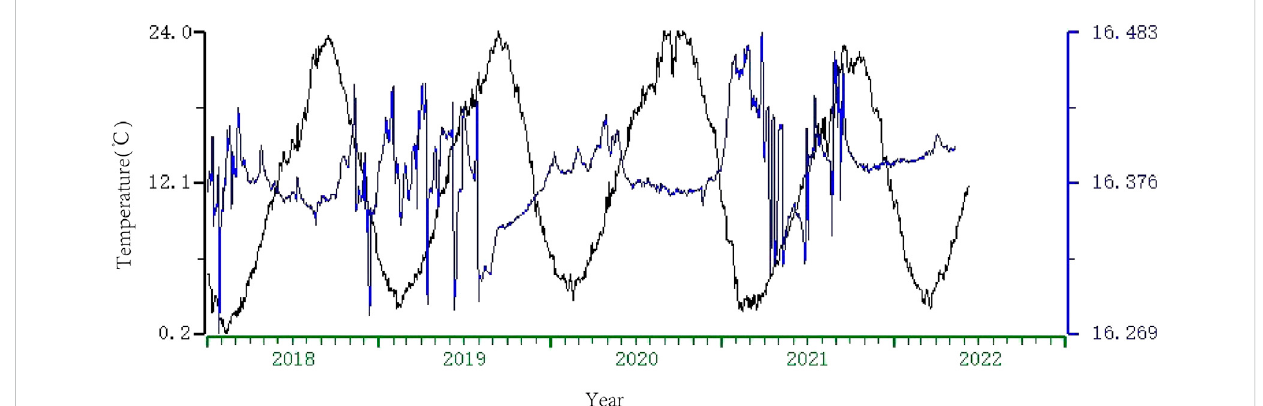
FIGURE 6 ComparisonoftemperaturebetweenCSTSTOSandtheNo.Lu32wellfromJanuary2018toMay2022.Theblacklineistheseawatertemperatureof CSTSTOS, and the blue line is the groundwater temperature of the No. Lu 32 well.